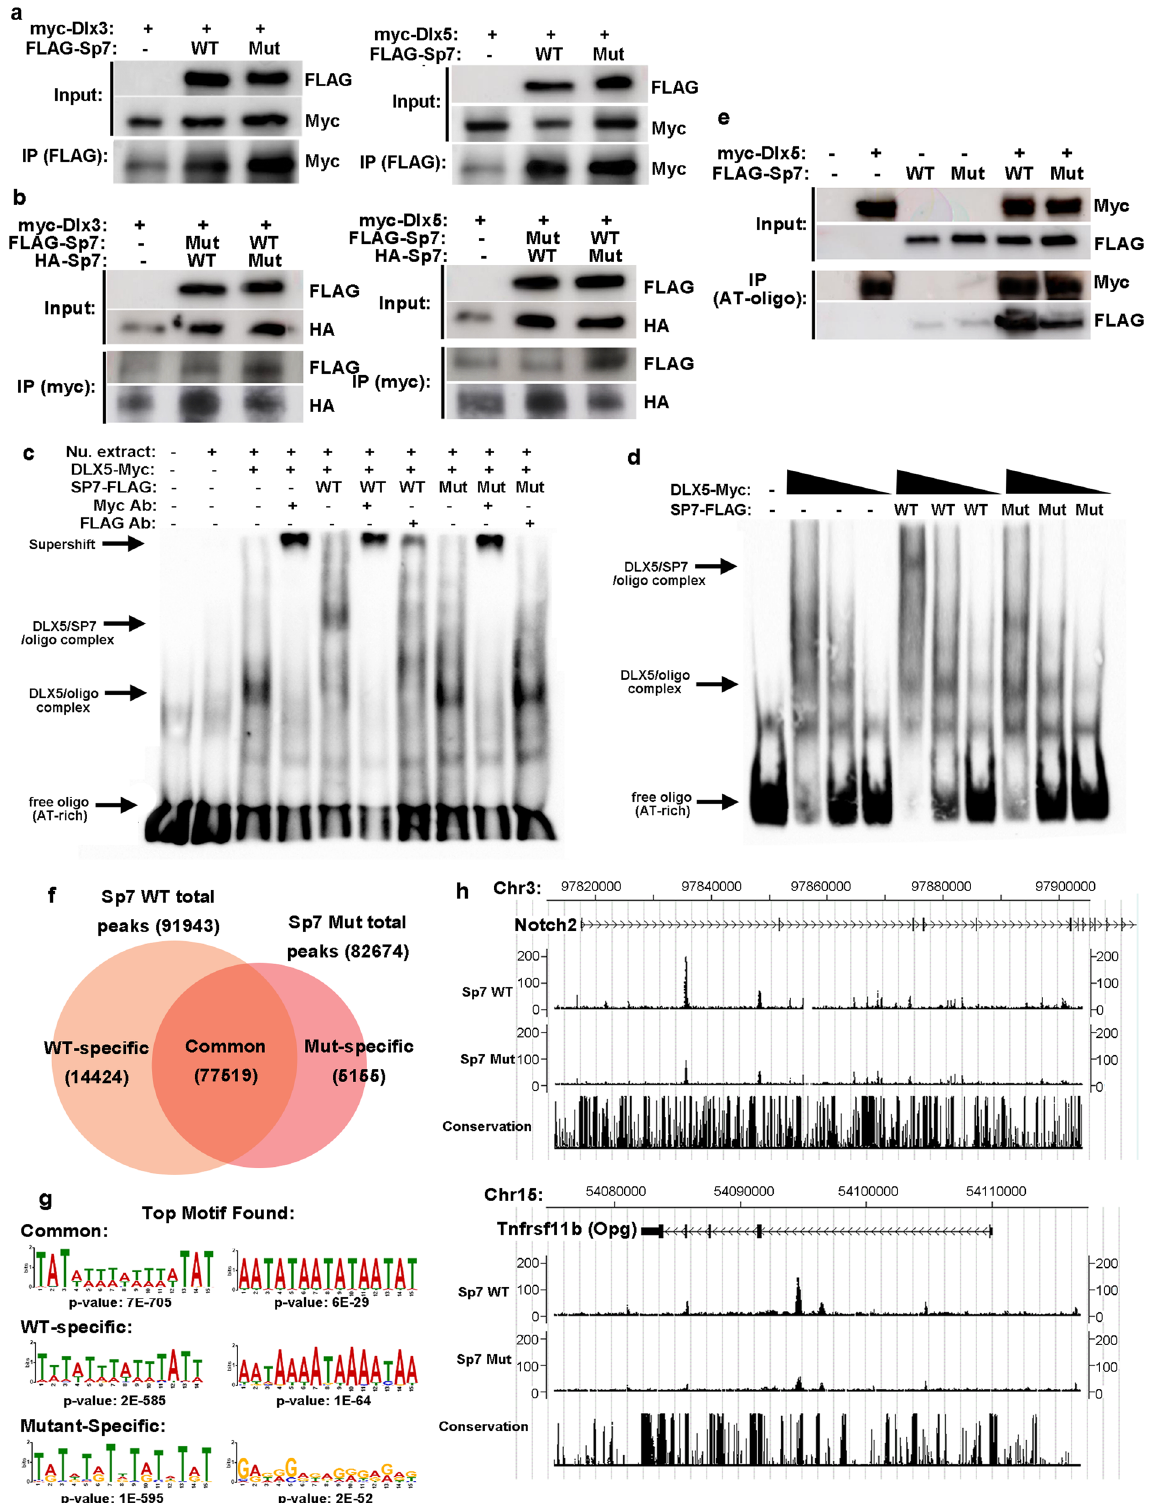
Animal procedures and generation of Sp7 S309W knock-in . All animals were used in accordance with the Guide for the Care and Use of Laboratory Animals (National Research Council 2003). The serine to tryptophan substitution at codon 309 was created by CRISPR-mediated genome editing directly in fertilized eggs of C57BL/J (The Jackson Laboratory) as described 36,37 . Target sequences for guide RNAs (gRNAs) near the target codon with minimal off-target hits were initially selected using the ranking tool CRISPR Design (http://crispr.mit.edu) and CRISPRScan.org 38 , synthesized with the MegaScript T7 kit (Ambion) and ef fi cacy